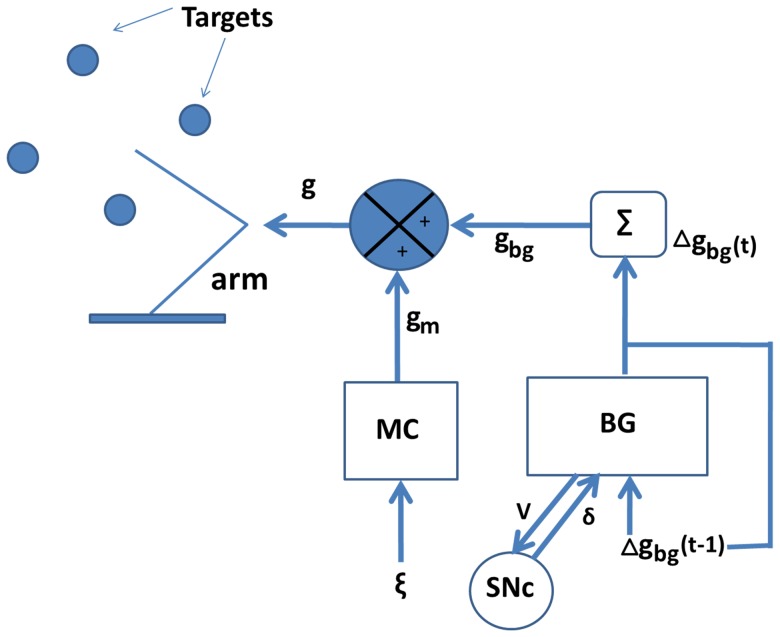
A model of reaching involving basal ganglia (redrawn based on [24]).